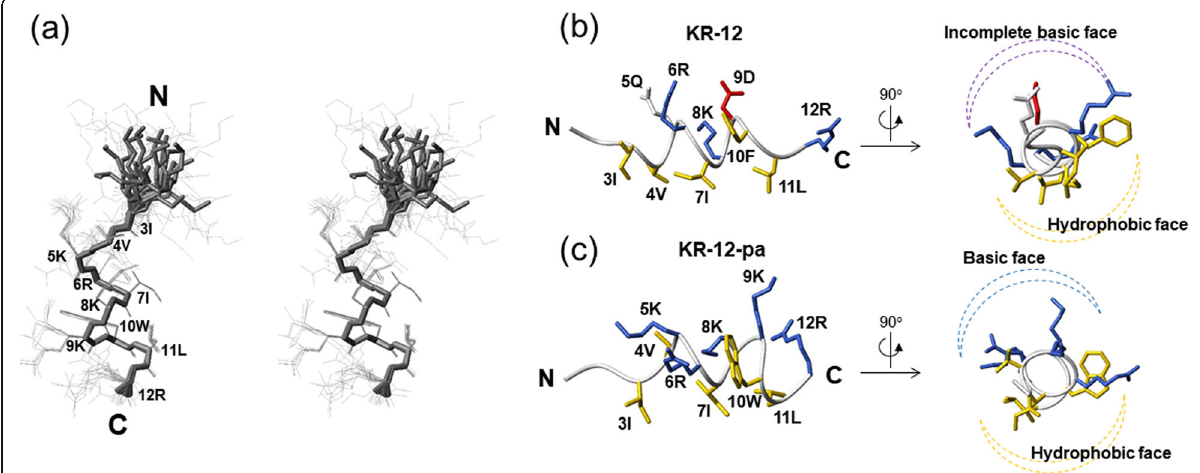
Fig. 4 NMR structure of KR-12-pa. a Stereo view of twenty converged line structures of KR-12-pa for backbone heavy atoms (N, C α , and C ′ ). N and C indicate N- and C-terminal positions, respectively. The lowest target function structure of KR-12 ( b ) and KR-12-pa ( c ). The side chains from residues 3 to 12 were shown with neon structure with labeling. Positively charged residues are in blue. Negatively charged residues are in red. Hydrophobic residues are in yellow. The basic and hydrophobic faces are indicated by dotted